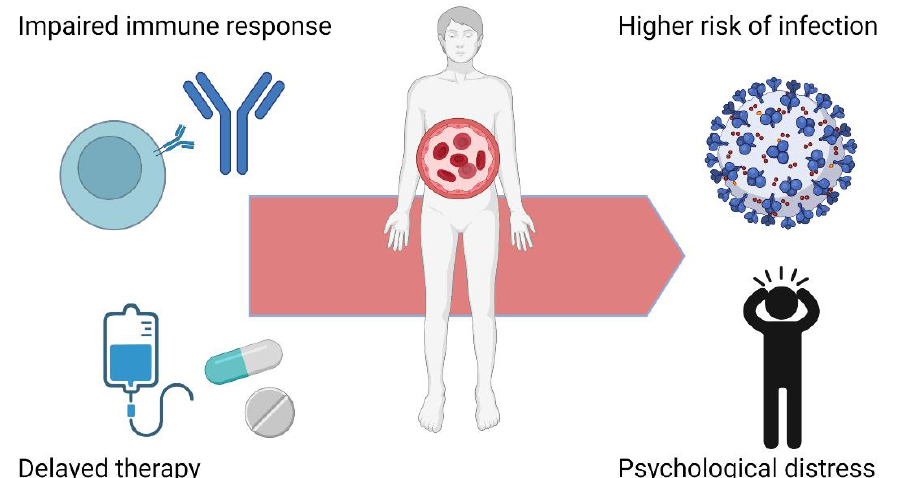
Figure 1. Impact of COVID-19 pandemic on HM patients. HM patients show an impaired immune response and suffered from delays of anticancer therapies during the pandemic. These conditions made them more vulnerable to infection and to develop psychological distress. Figure created with BioRender.